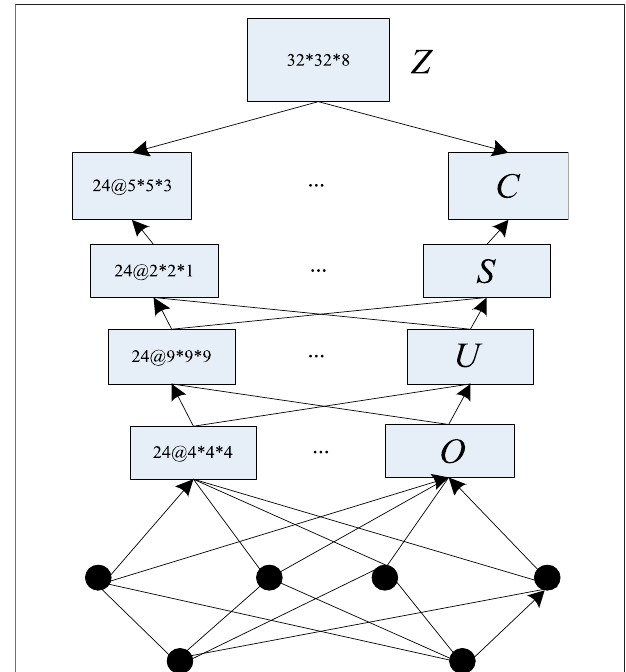
FIGURE 2 | 3D convolutional cloud neural network